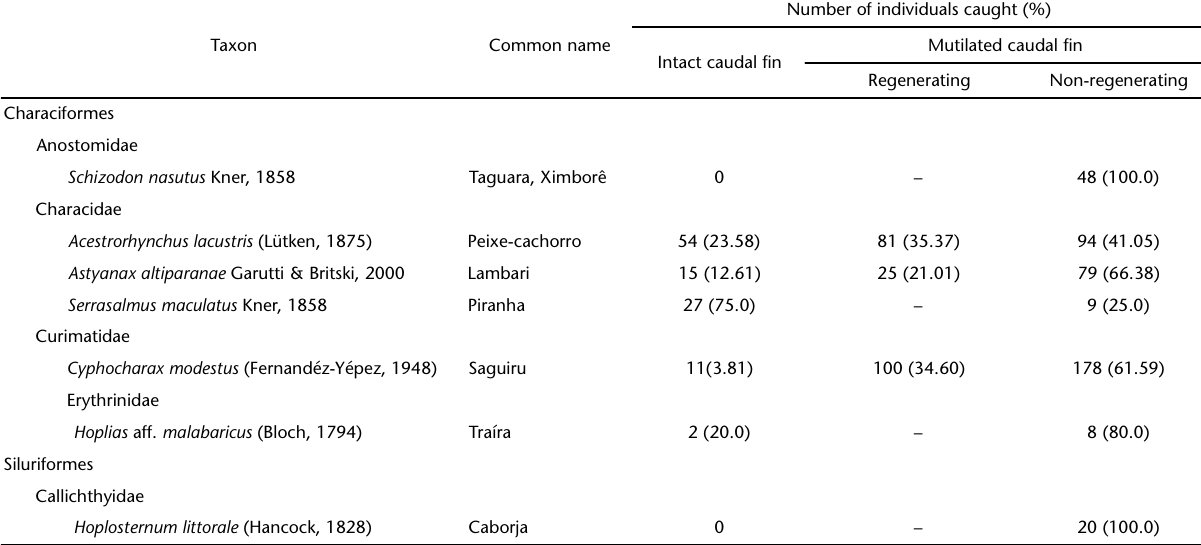
Table 1. List of species and number of individuals with intact or mutilated caudal fins, with discrimination of individuals with regenerating caudal fins (percentual number of individuals with intact or mutilated caudal fin, detaching regenerating of non-regeneration individuals, by